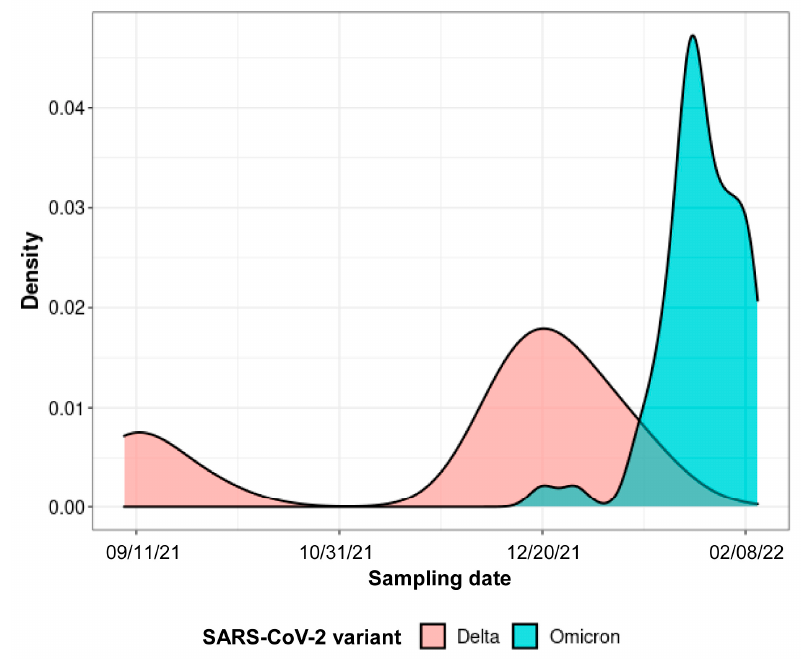
Figure 1. Dynamics of COVID-19-related hospital admissions and SARS-CoV-2 variant distribution between September 2021 and February 2022. Density chart representation.